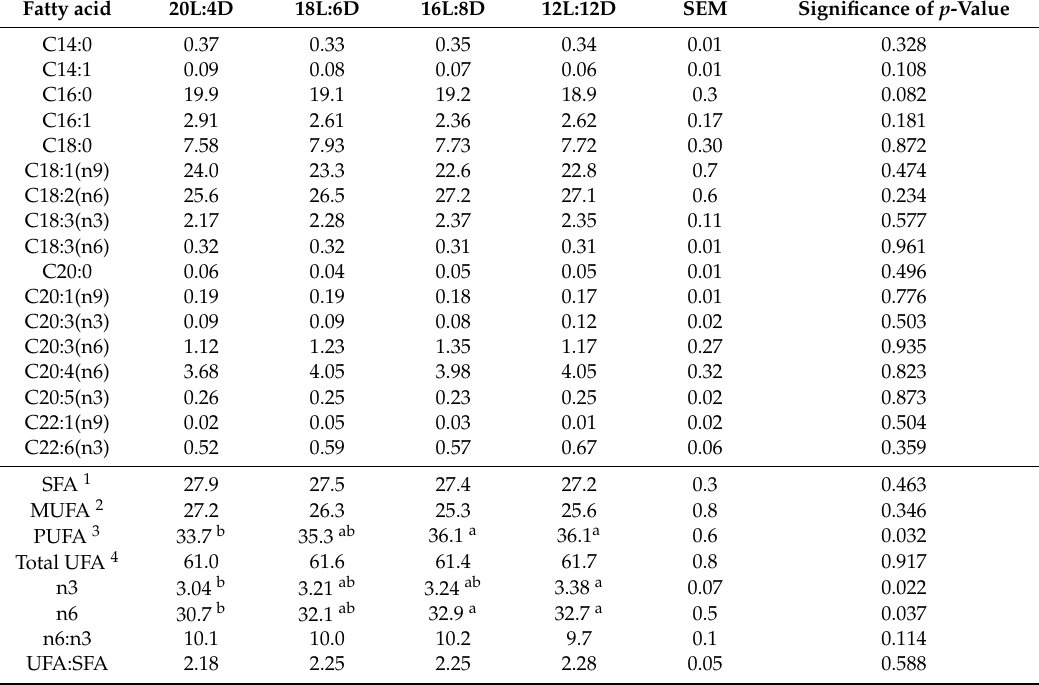
Table 6. E ff ect of photoperiod on the fatty acid profile (grams per 100 grams of intramuscular lipid) of broiler fillet ( M. Pectoralis major ) muscles ( n = 6 / treatment).